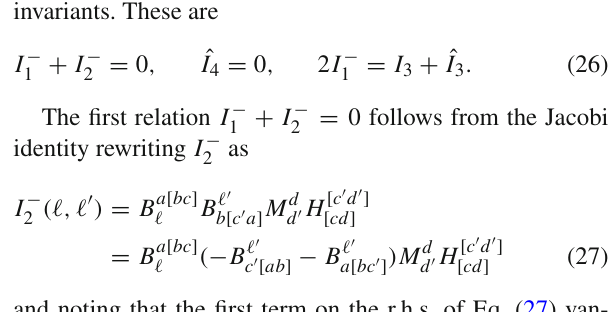
theflavorspacequarkmodelwavefunctions.Theproductofthedenom- inator factors appear as overall factors of the process specification in column